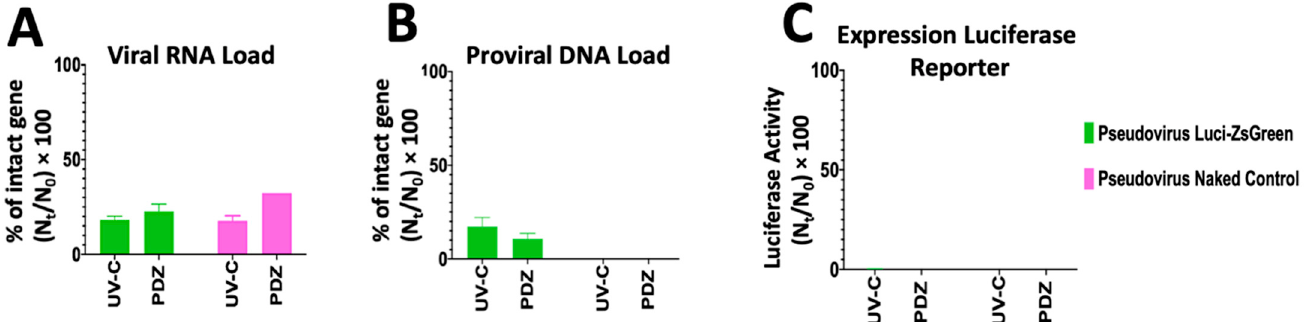
Figure 4. The pseudovirus has been treated with either 36 s UV-C irradiation or 10 min Photodynamic Inactivation in the presence of 50 μ g/mL Photodithazine. The mechanism of infectivity of photo-inactivated pseudovirus particles has been compared on three levels; ( A ) viral RNA load referring to the free-cell virus; ( B ) proviral DNA load referring to the ability of the treated virus to complete the subsequent steps of cell internalization, reverse transcription and genome integration; ( C ) luciferase activity referring to the expression of luciferase reporter after DNA integration. n t /n 0 represents the fraction of the targeted genome region that remained intact after treatment.